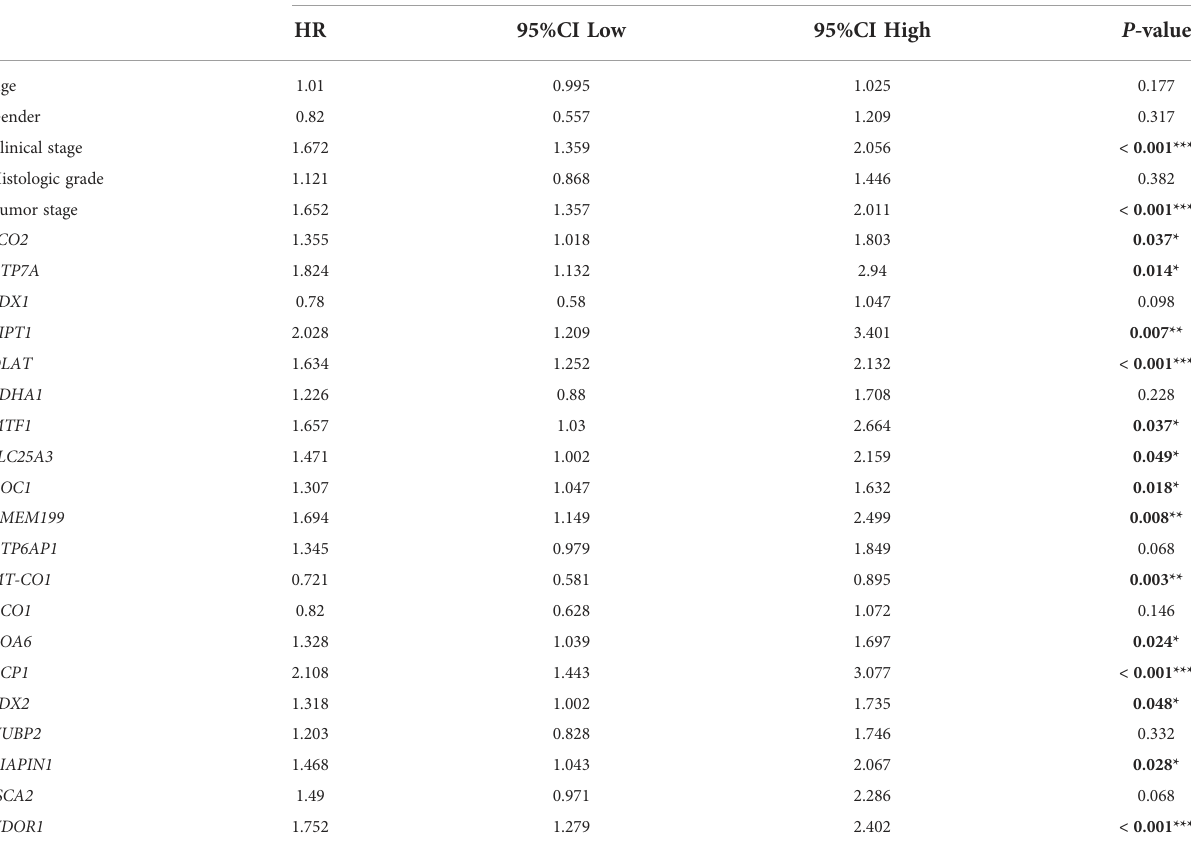
TABLE 1 Univariate Cox regression analysis for prognosis risk factors of HCC